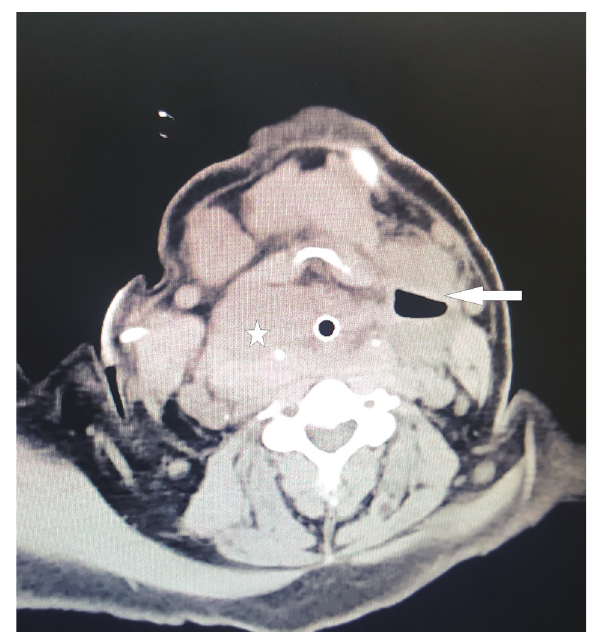
Patient is intubated. A thin-walled peripherally enhancing cystic lesion is seen in the right supra/paraglottic, extending through the thyrohyoid membrane (asterisk). Another cystic lesion with air fluid level is seen on the left side of the larynx